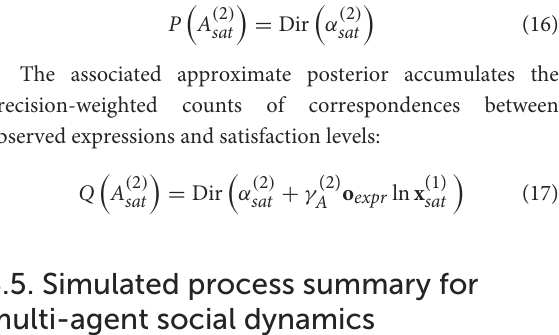
FIGURE6 A depiction of the community square with its initial opinion distribution: One idea (red) was supported by almost all agents, with some variation due to individualized model parameters, roughly dividing into “strict conservatives,” “centrists,” and a few “skeptics.” At first, the alternative idea (blue) is supported by only one, stubborn agent